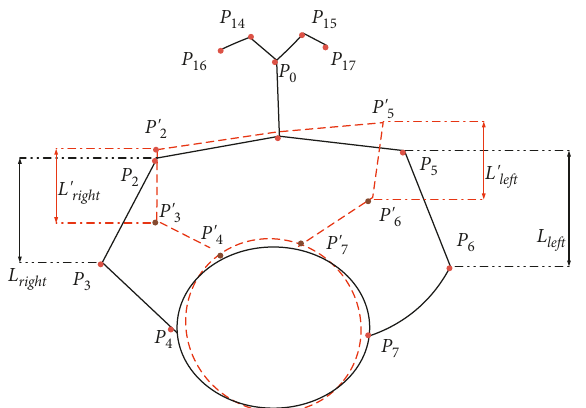
Figure 4: Schematic diagram of area changes between